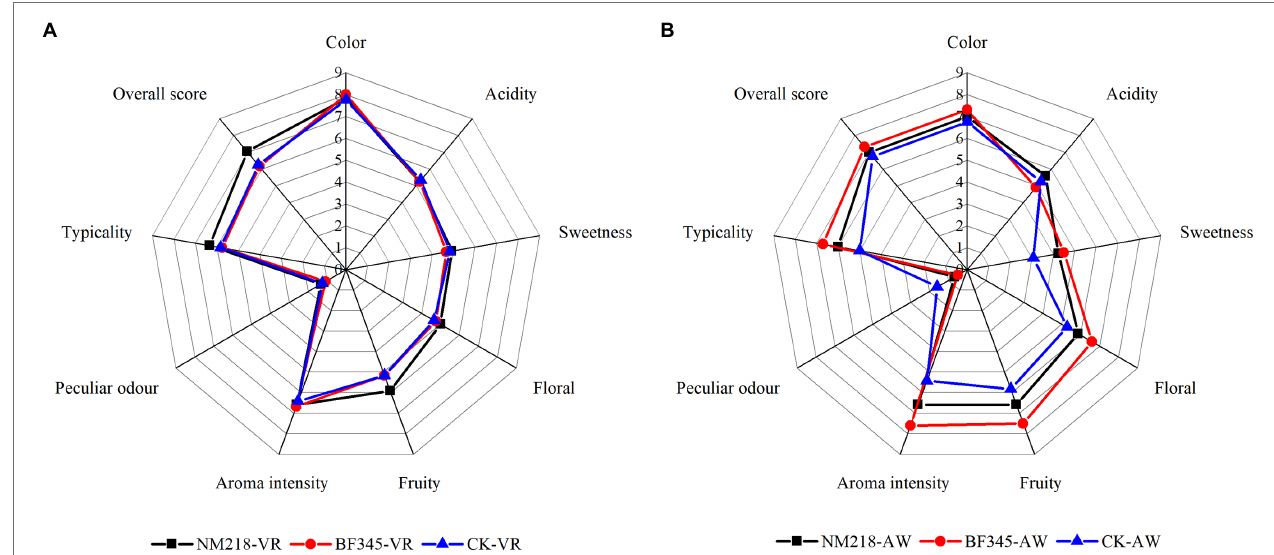
FIGURE 6 | Sensory evaluation radar chart of wines. (A) Cabernet Sauvignon wines and (B) Chardonnay wines. CK-VR; pure culture of S. cerevisiae (VR) used as a control in Cabernet Sauvignon wines. NM218-VR; sequential inoculation of M. guilliermondii NM218 and VR at 48 h in Cabernet Sauvignon wines. BF345-VR; sequential inoculation of H. uvarum BF345 and VR at 24 h in Cabernet Sauvignon wines. CK-AW; pure culture of S. cerevisiae (AW) used as a control in Chardonnay wines. NM218-AW; sequential inoculation of M. guilliermondii NM218 and AW at 48 h in Chardonnay wines. BF345-AW; sequential inoculation of H. uvarum BF345 and AW at 24 h in Chardonnay